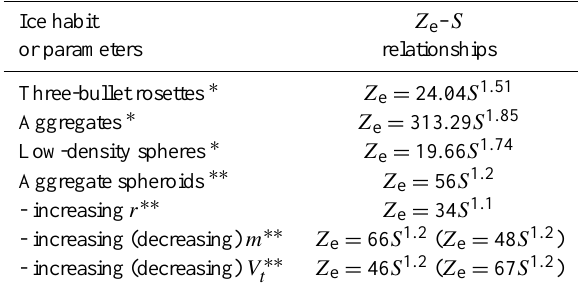
Table 5. Z e – S relationships ( Z e in mm 6 m − 3 , S in mmw.e.h − 1 ) for dry (unrimed) snow for various snowfall particle shapes and pa-